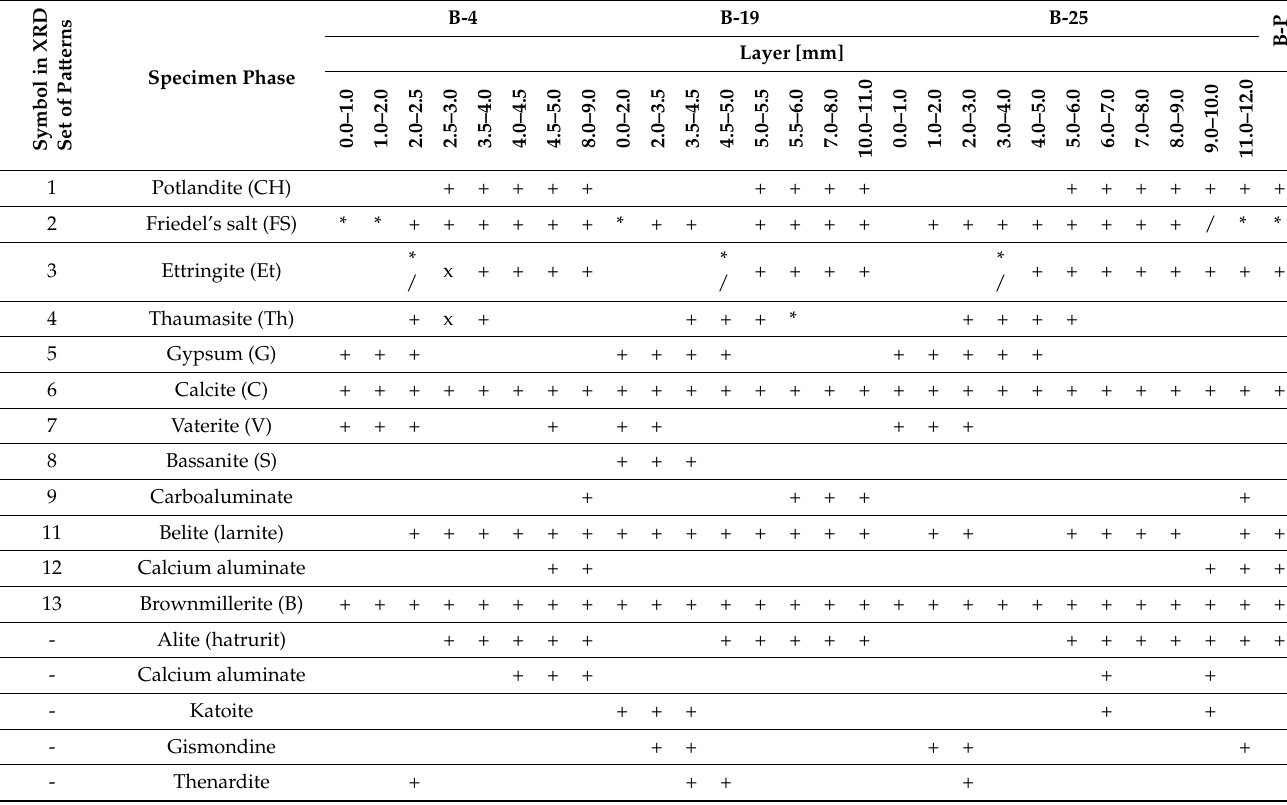
Table 6. Occurrence of crystalline phases in layers of corroded and reference